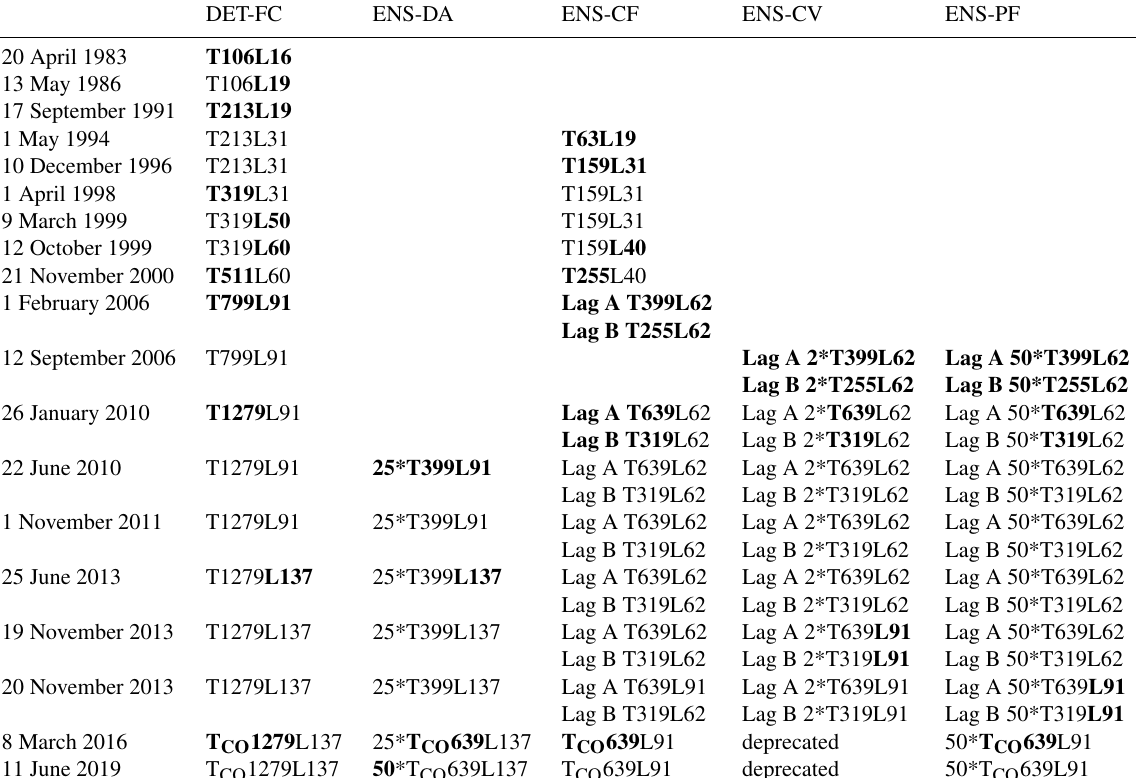
Table 2. List of the evolution of the spatial resolution of the IFS operational forecasts. Changes are marked in bold. The ensemble data are usually provided with higher resolution for Lag A (1–10d) than for Lag B (10–15d). The first part of each entry is the horizontal resolution marked with a “T” for spectral representation; with “T” representing the linear and “T CO ” the cubic octahedral representation. The second part, marked with “L”, is the number of vertical model levels. In the case of ensembles, the number N of members is written in front of the resolution as N ∗ . Source: Palmer et al. (1997), Buizza et al. (2003), ECMWF (2019c,e,f,g). DET-FC ENS-DA ENS-CF ENS-CV